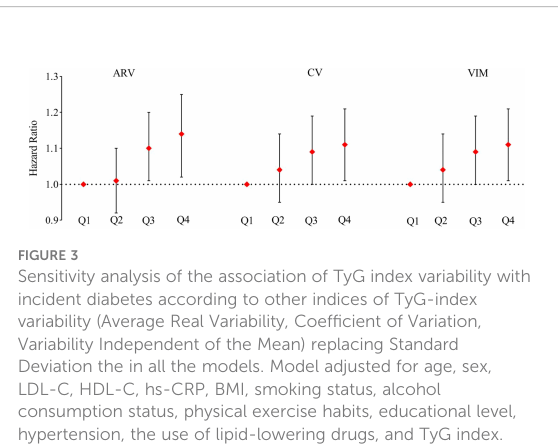
FIGURE 2 Kaplan-Meier incidence rate of diabetes by TyG-index variability (SD).